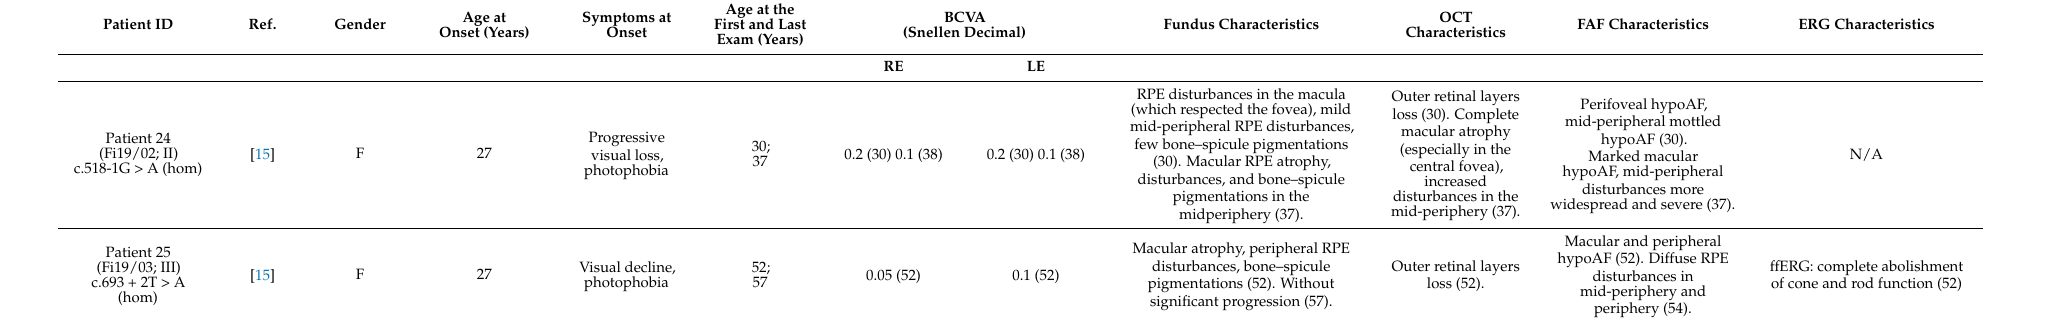
ffERG:completeabolishment